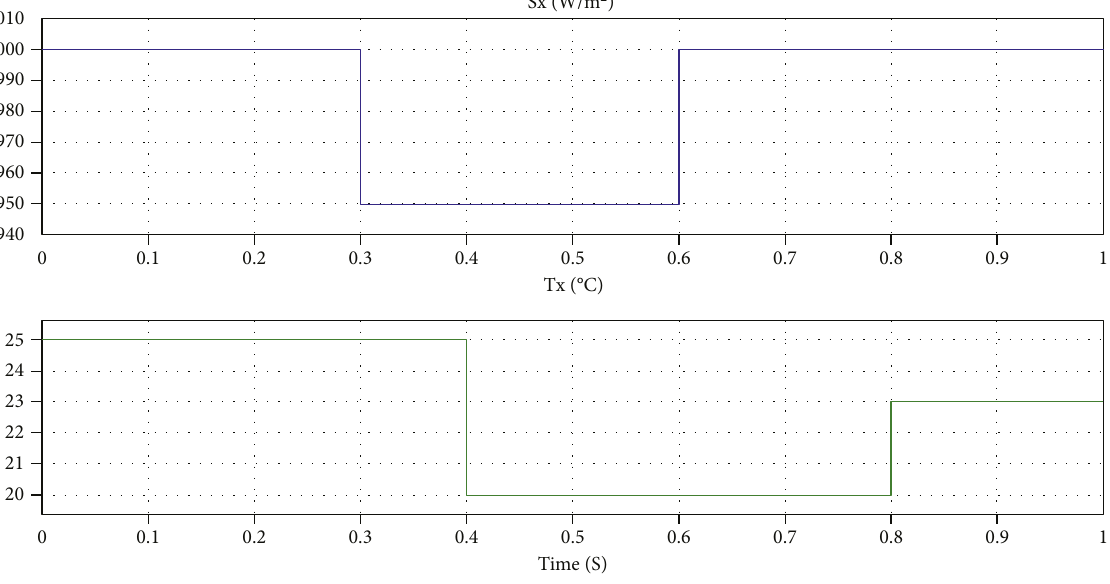
Figure 8: Ambient solar irradiation level and temperature